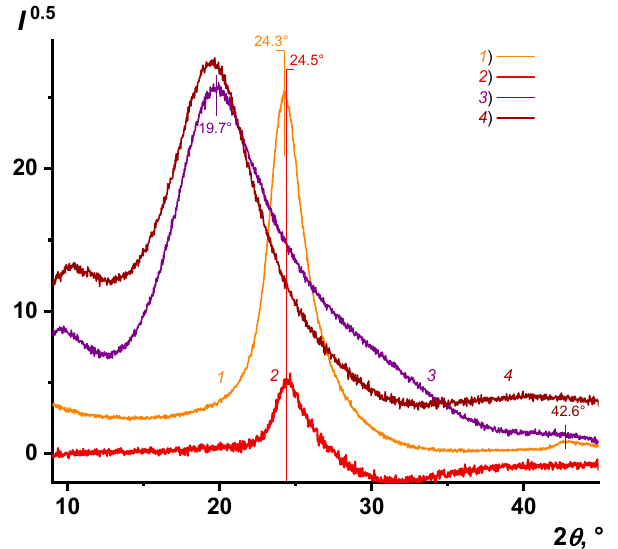
Figure 4. XRD patterns of initial r-GO(H ₂ ) flakes ( 1 ), surface modified ones ( 2 ), polystyrene ( 3 ), and composite 2 ( 4 ). Table 2. XRD analysis data of initial and surface modified r-GO flakes using Scherrer’s equation (1) .